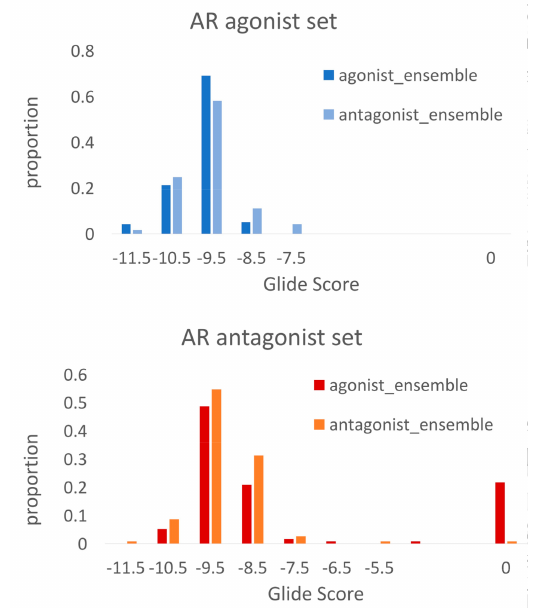
Figure 6. Docking score distributions for agonist and antagonist ligands docked to the agonistic and antagonistic receptor